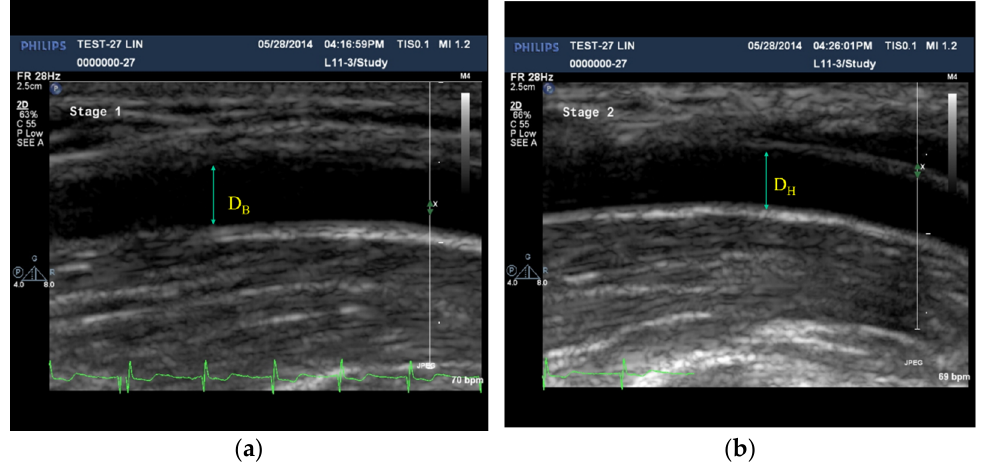
Figure 5. ( a ) The BAUS image used to measure the diameter (D B ) before the ischemic stress, ( b ) the image by BAUS used to measure the diameter (D H ) in the hyperemia reaction phase.